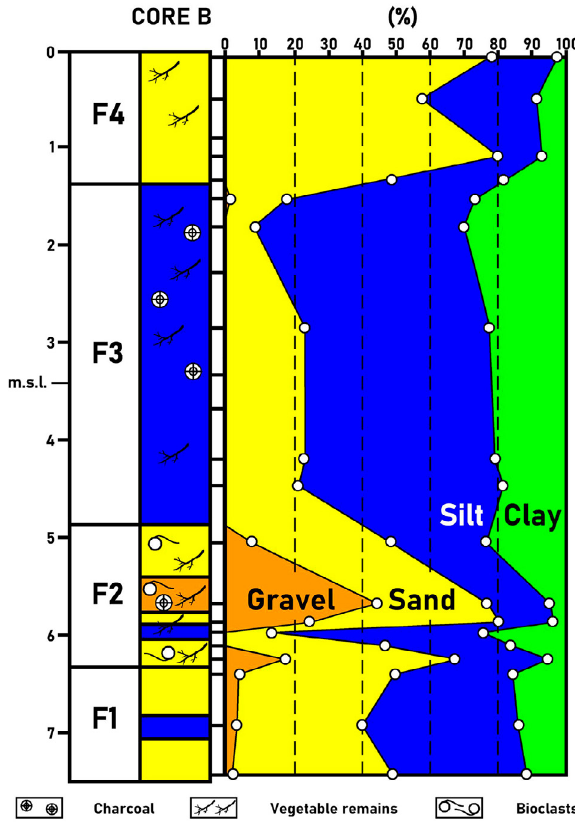
Fig. 2. – Textural analysis of core B.